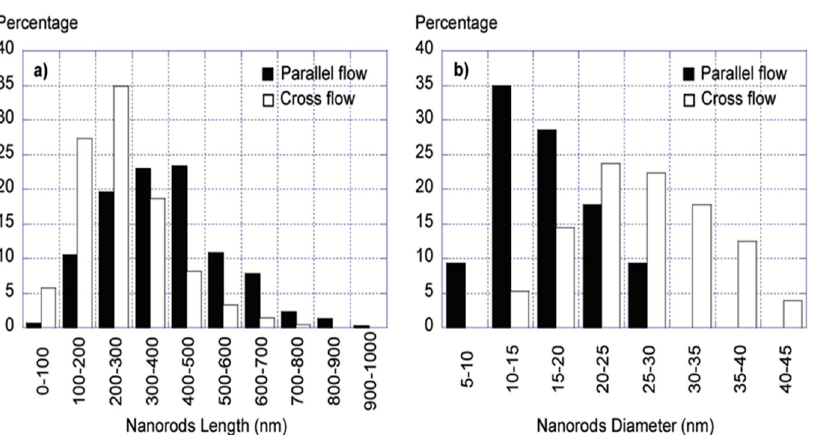
Figure 7. Histogram of nanorods length ( a ) and diameter 9 ( b ) distribution for ZnO nanorods synthesized by parallel flow and crossflow. Reprinted with permission from [38]. Copyright (2009) American Chemical Society.